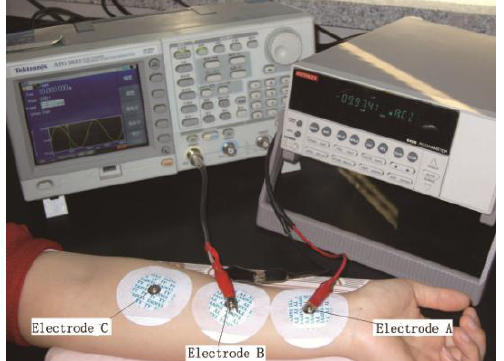
Figure 3. Skin resistance measurement based on a three-electrode system (static